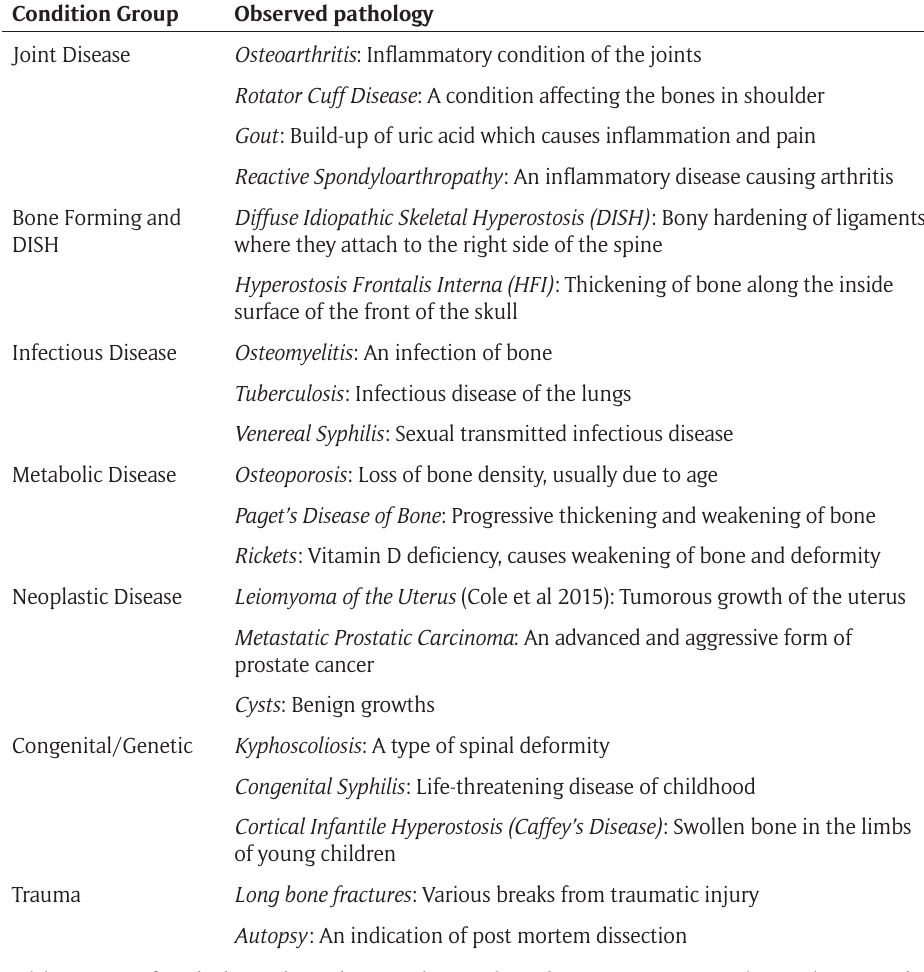
Table 1: List of pathological conditions observed on the Eastgate Square (ESC11)